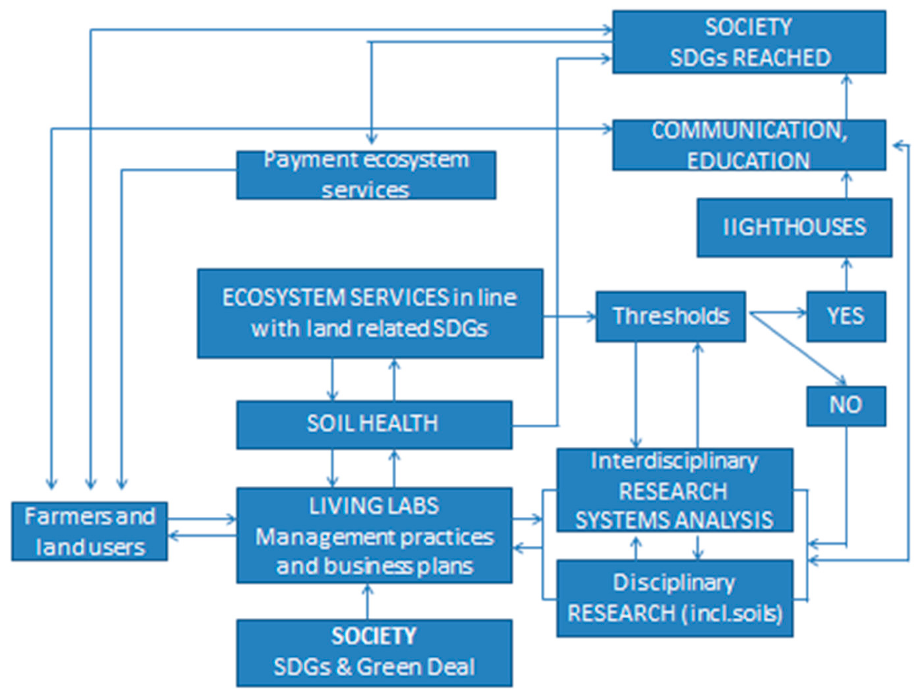
Figure 1. Schematic representation of procedures discussed in this paper, linking farmers’ experience with research in living labs focused on achieving ecosystem services in line with the SDGs and the Green Deal (see text).